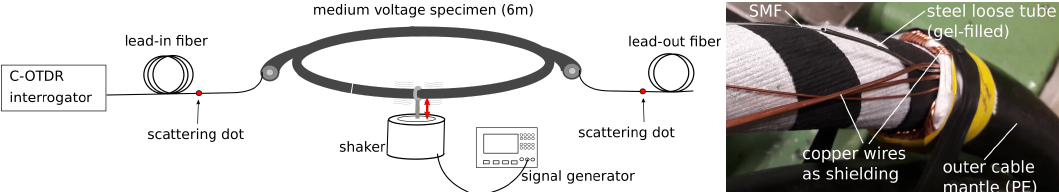
Figure 9. Left: setup for vibration sensing in a medium voltage cable. One scattering dot was spliced into each the lead-in fiber and the lead-out fiber, respectively, resulting in a distance between them of 6.7 m. Right: detailed view of one end of the power cable with single mode optical fiber (SMF) in stainless steel loose tube embedded in the shielding layer made up of copper